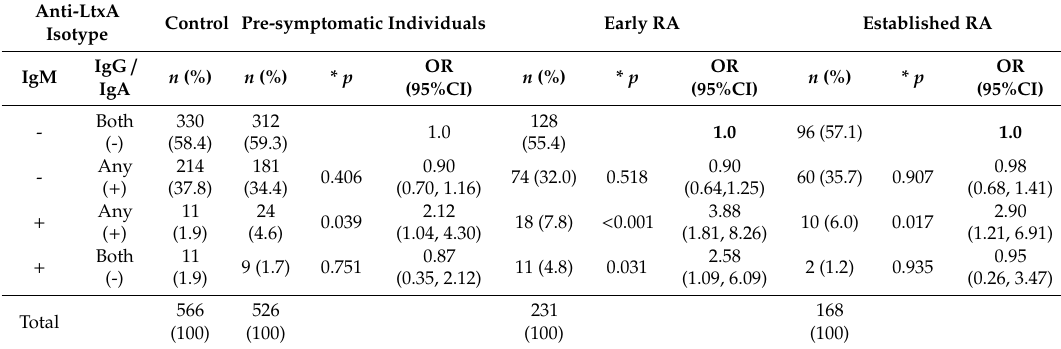
Table 2. Aa exposure in study subjects according to anti-LtxA antibody isotype.